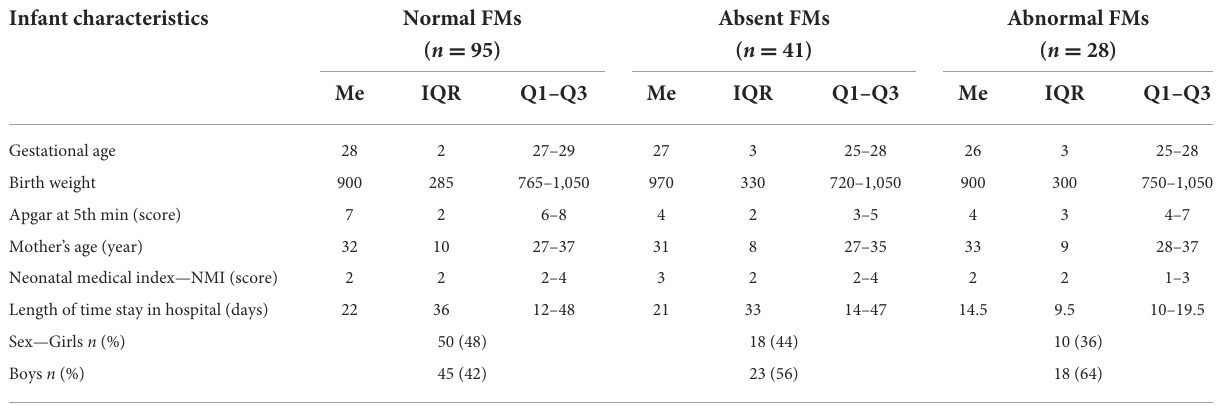
TABLE 2 Characteristics of children included in an individual